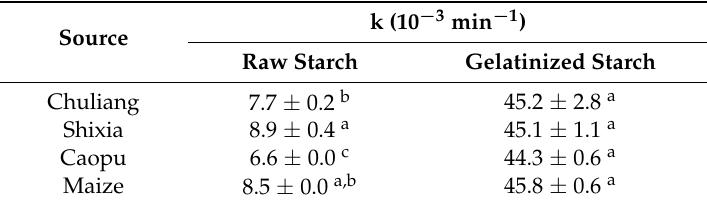
Figure 4. Digestogram of raw ( A ) and freshly gelatinized ( B ) longan seed starch as compared with normal maize starch. Table 3. The digestion rate coefficient (k) of raw and freshly gelatinized longan seed starch and normal maize starch 1